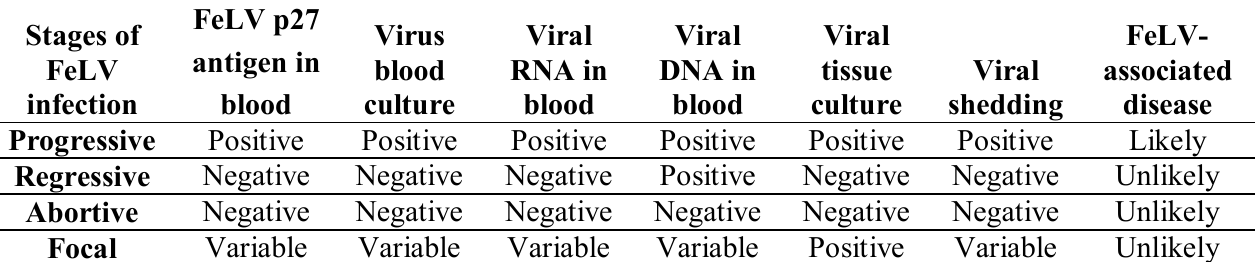
Table 1. Stages of feline leukemia virus (FeLV)